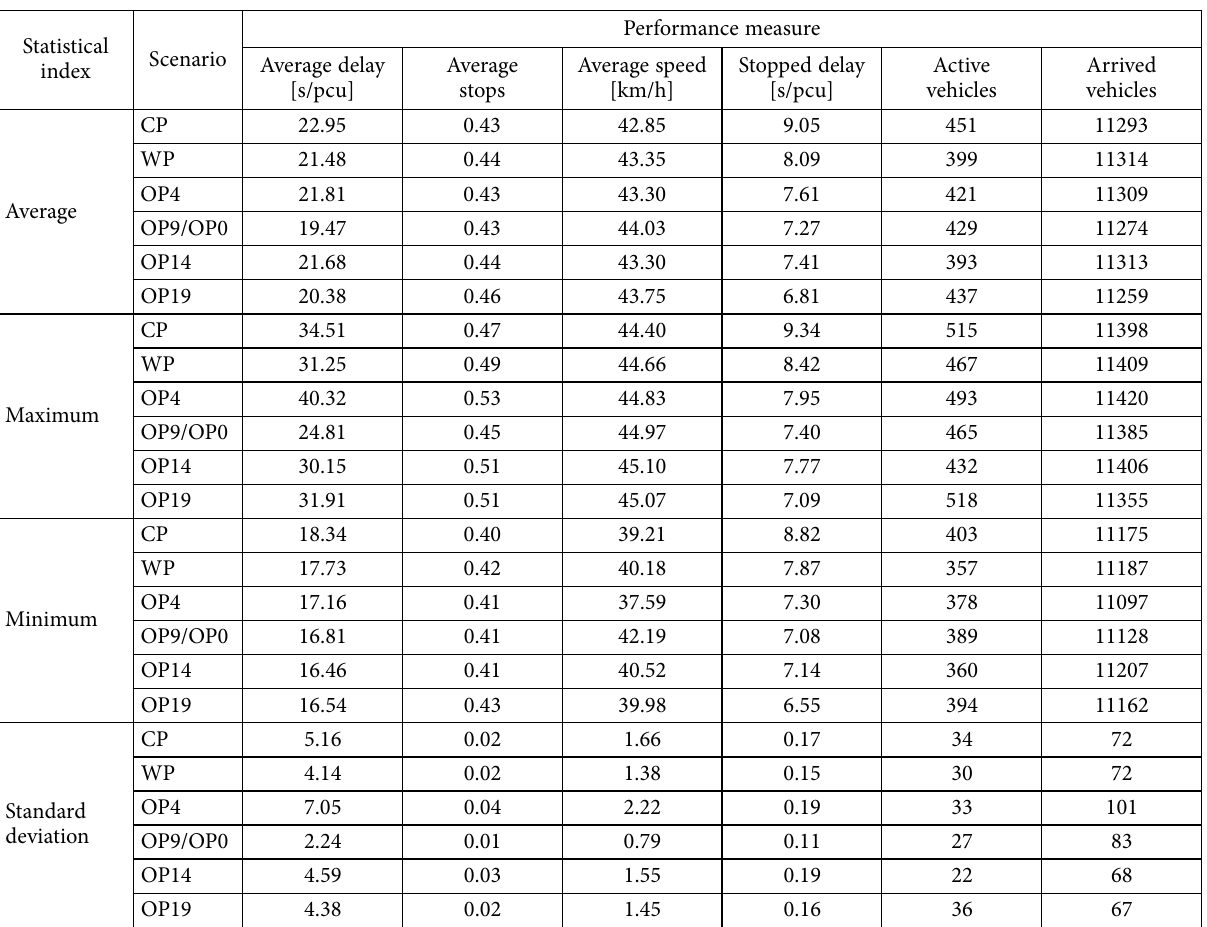
Table 8. Comparison of network performance